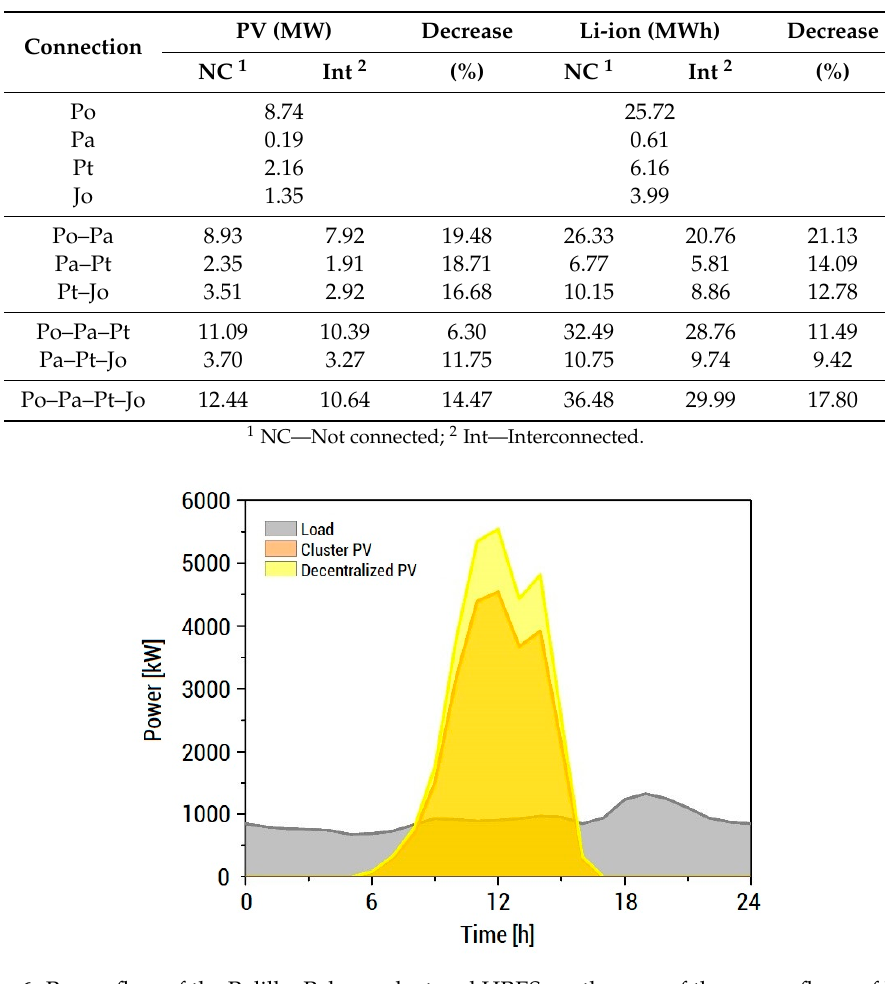
Table 9. Optimum sizes of the decentralized and clustered HRES simulations from HOMER Pro.